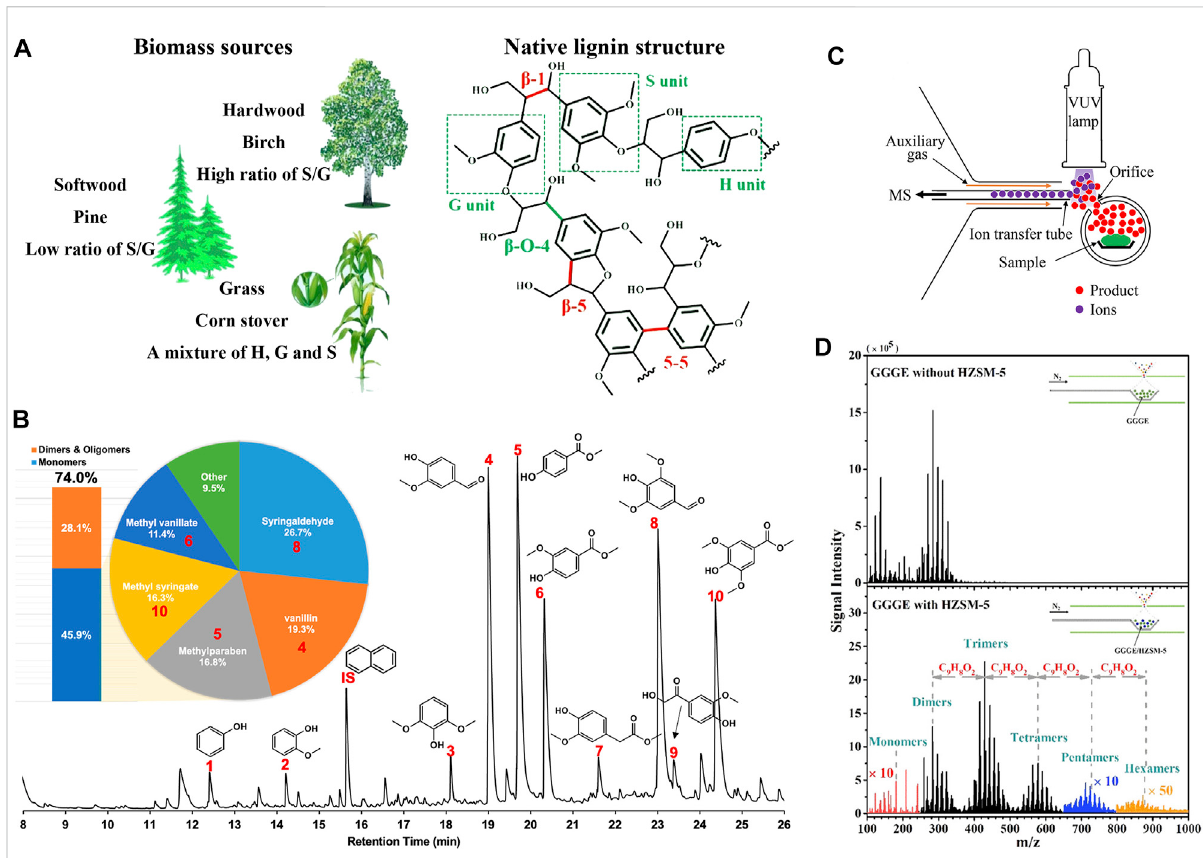
FIGURE 1 (A) Different sources and arepresentativestructuralfragmentofnative lignin,where H,G,and Sunits represent p-hydroxyphenyl,guaiacyl, and syringyl units, respectively. Reprintedfrom Cao etal. (2020), with permission from American Chemical Society (Copyright2020). (B) Chromatogram of lignin depolymerization products which were identi fi ed by GC/MS and quanti fi ed by GC-FID, and yield of products with different degrees of polymerization.ReprintedfromDuetal.(2021),withpermissionfromAmericanChemicalSociety(Copyright2021). (C) Experimentalsetupof in situ APPI MS method. Reprinted from Chen et al. (2020), with permission from American Chemical Society (Copyright 2019). (D) The comparison of mass spectra of guaiacylglycerol- β -guaiacyl ether (GGGE) pyrolysis with/without catalyst. Reprinted from Liu C. et al. (2020), with permission from Wiley-VCH GmbH (Copyright